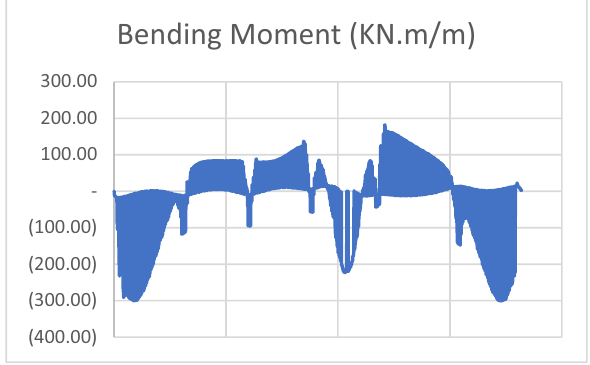
Figure 7: Bending moment distribution under the footing of the western